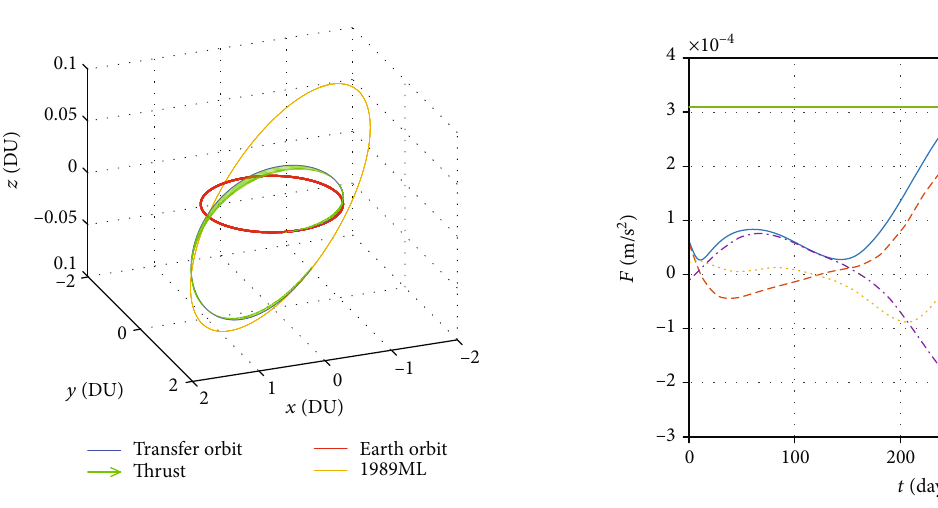
Figure 8: Optimal transfer trajectory of Earth-asteroid 1989ML.